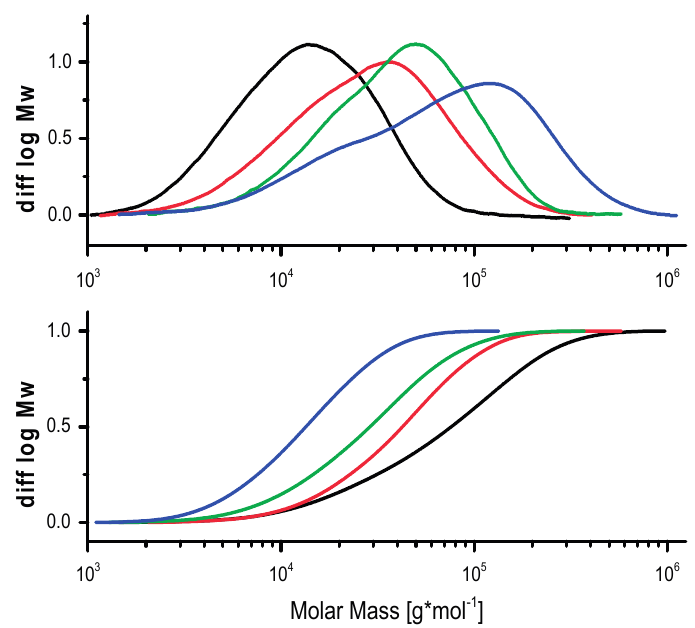
Figure 4. Differential (top) vs. cumulative distribution of molar mass (cellulose degradation